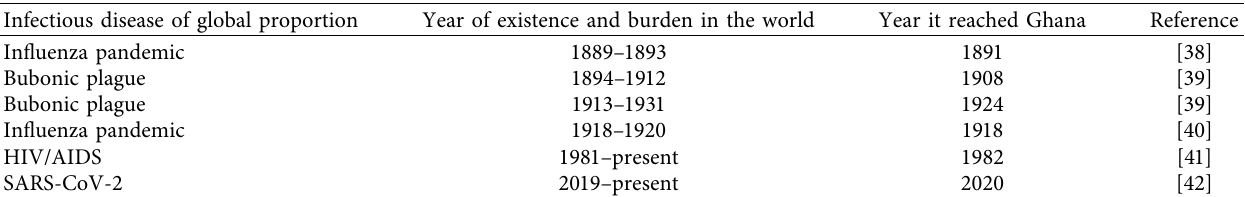
Table 3: The transition of IDs that caught global attention, their years of existence and burden in the world, and the year they reached Ghana.